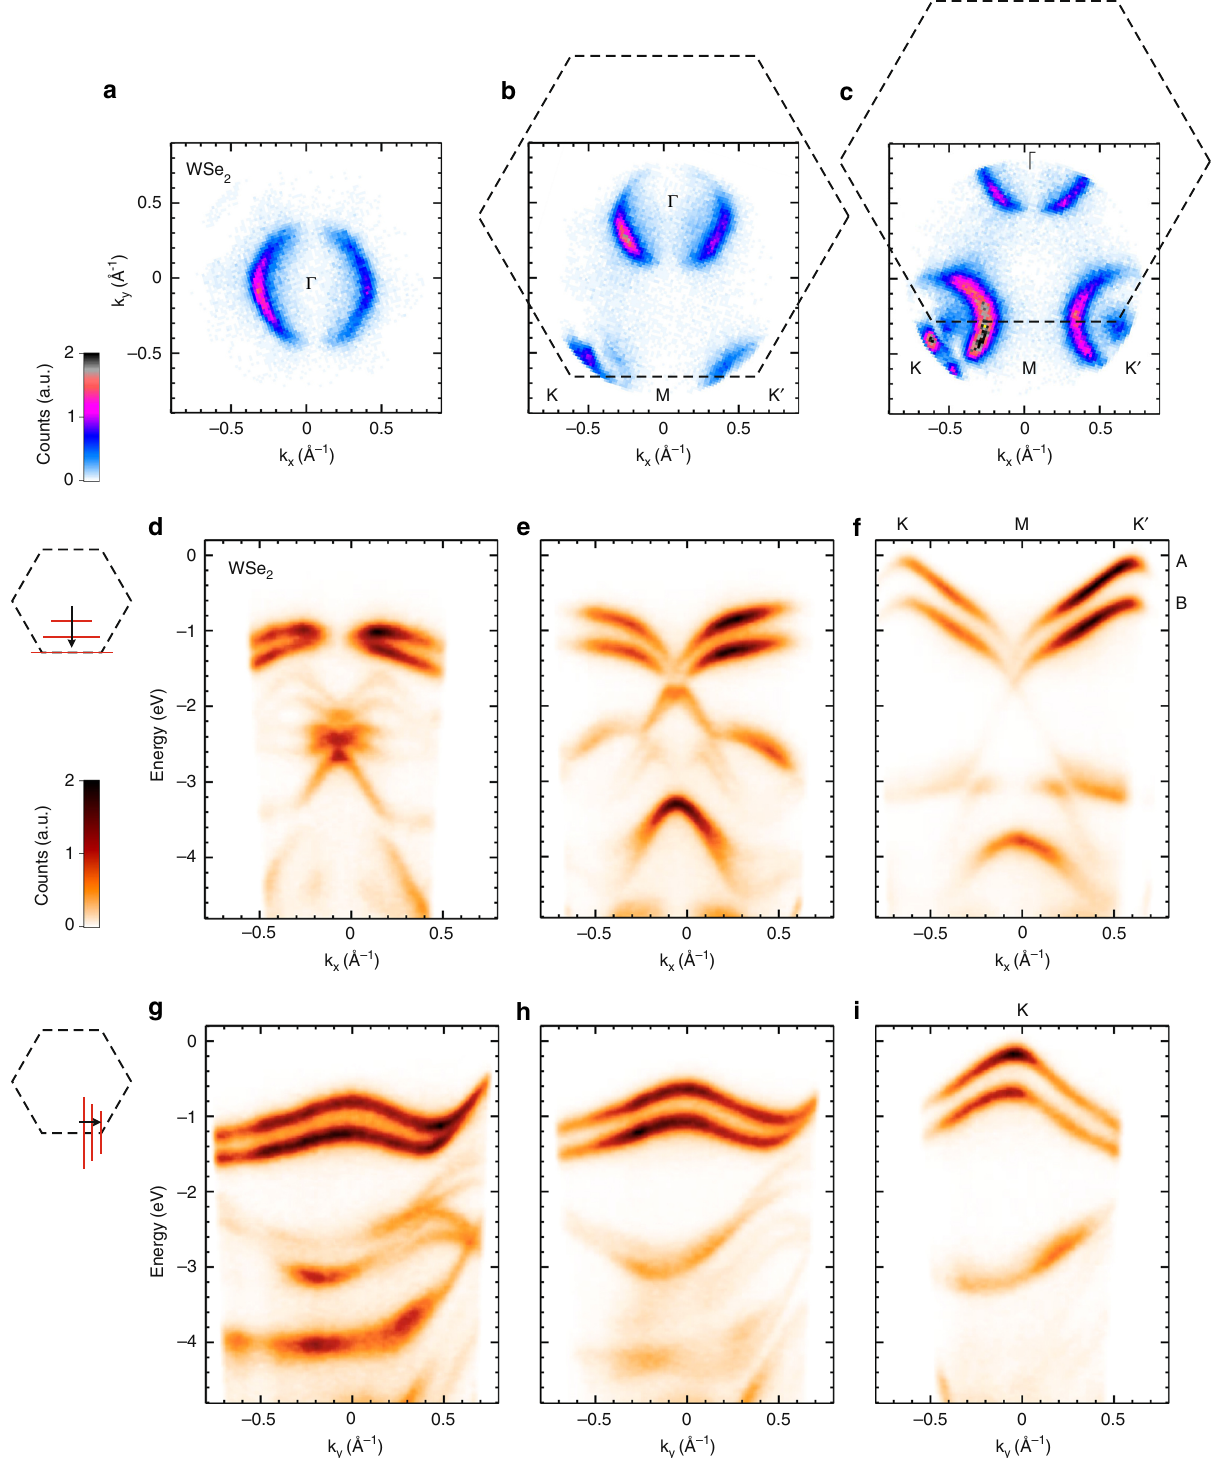
Fig. 6 WSe 2 semiconductor. ARPES measurement of bulk WSe 2 with 30-eV photons at a sample temperature of 30 K. a – c constant energy surface at energy slightly below the valence band top. Subsequent panels from left to right are obtained by tilting the sample (0°, 9°, 18°) to reach the K and K ′ valleys in the BZ. The right panel shows the A and B valence bands at the K and K ′ valleys. d – f E ( k x ) linecuts as k y is varied between Γ and M. g – i E ( k y ) linecuts as k x is varied between M and K are curved such that the XUV light is collimated toward the grating. We select con fi guration. We implement the X-ray Czerny-Turner (XCT) design that has a three gratings with different blaze angles and groove densities, to operate the symmetric optical layout with respect to the grating. There are two arms — one monochromator at three different photon energies and resolutions: 500 g/mm between the light source and M1, the other one between M2 and the exit slit — each (blaze angle 4.7°), 964 g/mm (14.6°), and 1200 g/mm (26.7°). Each grating has a has a nominal focal length of 800mm and dimension of 85 ×30 × 12mm. M1 and dimension of 75 ×30 × 9.1mm. The three gratings are mounted in parallel on a M2 are identical but 180° rotated with respect to each other. Their toroidal surfaces